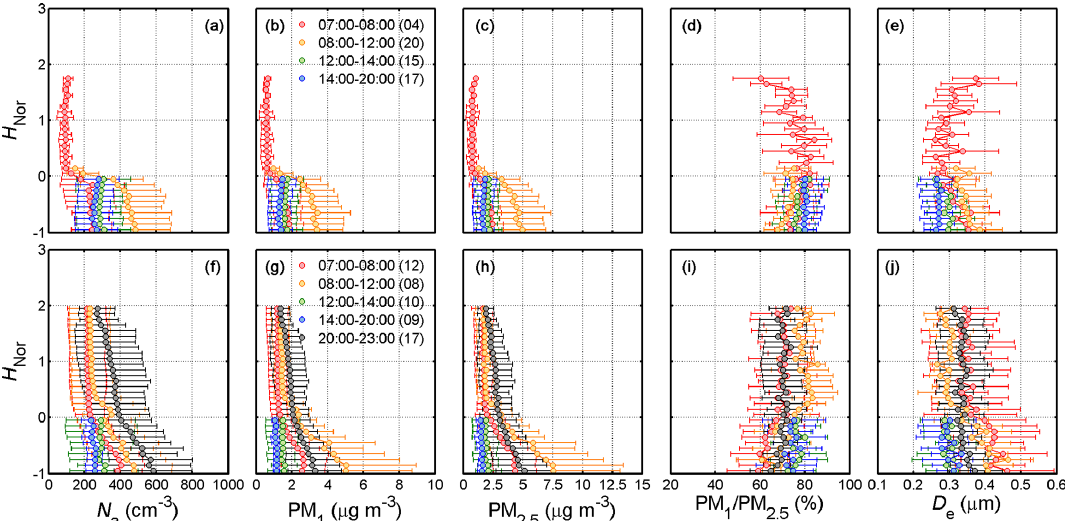
Figure 3. Average vertical profiles of (a) the particle number concentration ( N a ), (b) PM 1 mass concentration, (c) PM 2 . 5 mass concentration, (d) the ratio of PM 1 to PM 2 . 5 mass concentration, and (e) the effective diameter ( D e ) over the whole size range of the POPS, along the normalized height ( H Nor ) during Period I. Profiles for different time periods are shown in different colors, with dots representing average values and error bars representing standard deviations at each of the H Nor . The number of data points used for averaging at each H Nor was more than about 75% of the number of profiles during each time period, as given in parentheses. Average vertical profiles measured during Period II are displayed in the same way in panels (f) – (j) . Table 1. Particle parameters within the PBL, in the RL, and in the FT for Periods I and II, given as average value ± standard deviation and the range in parentheses. The number of profiles for each category is also given in parentheses in the second